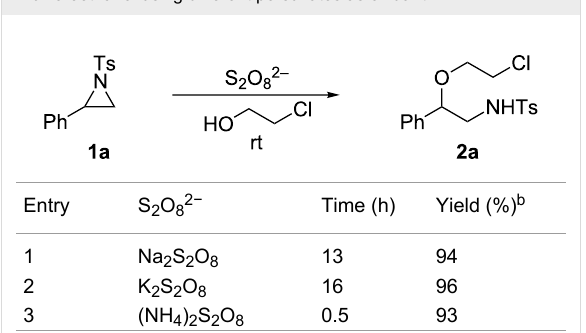
Table 1: Metal-free ring opening of 2-phenyl- N -tosylaziridine ( 1a ) with 2-chloroethanol using different persulfates as oxidant.